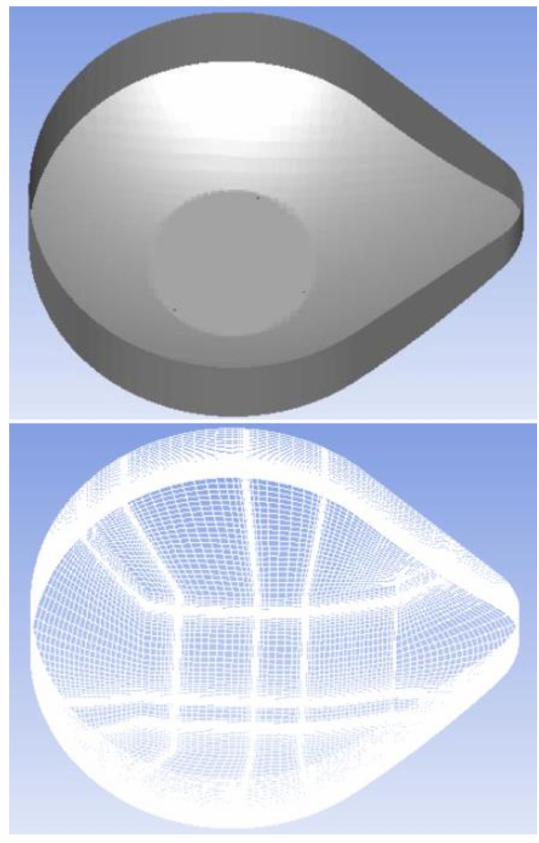
Figure 2. Simulation and grid diagram of the